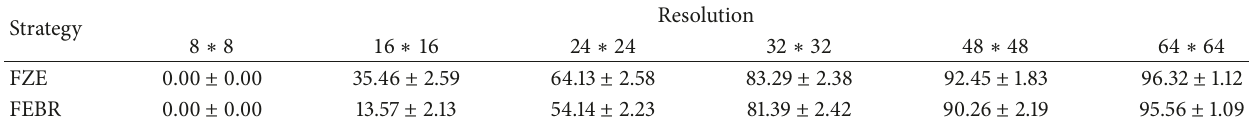
Table 2: Results of the object recognition rate under different resolutions.